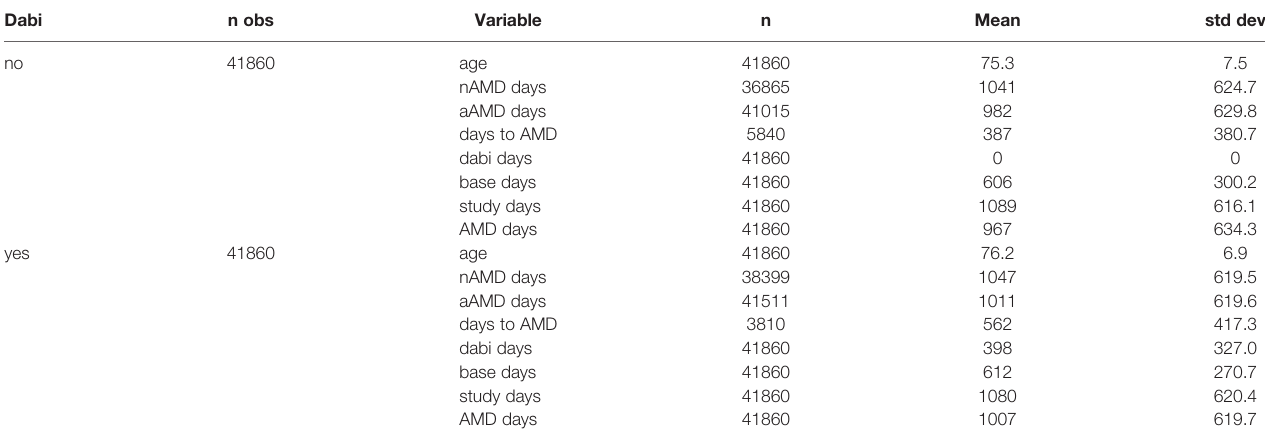
TABLE 1 | Characterization of control and dabigatran-exposed subjects. Dabi